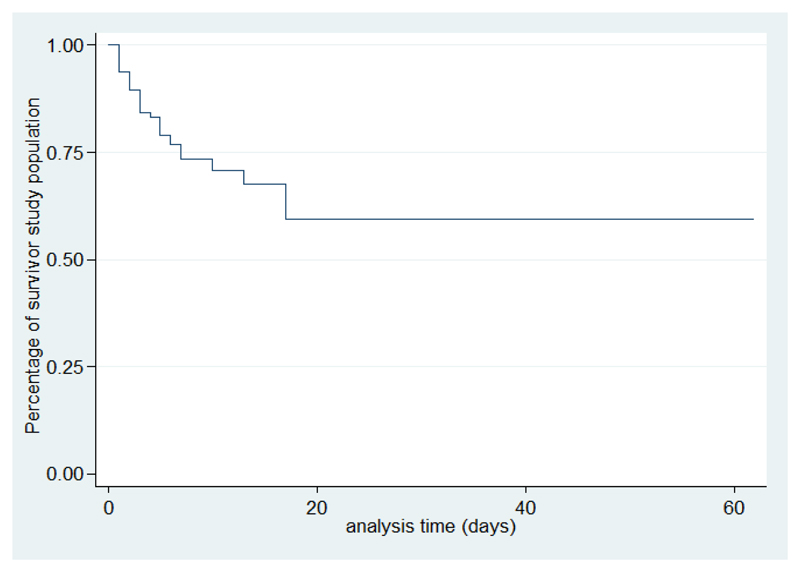
Survival analysis curve of Kaplan-Meier